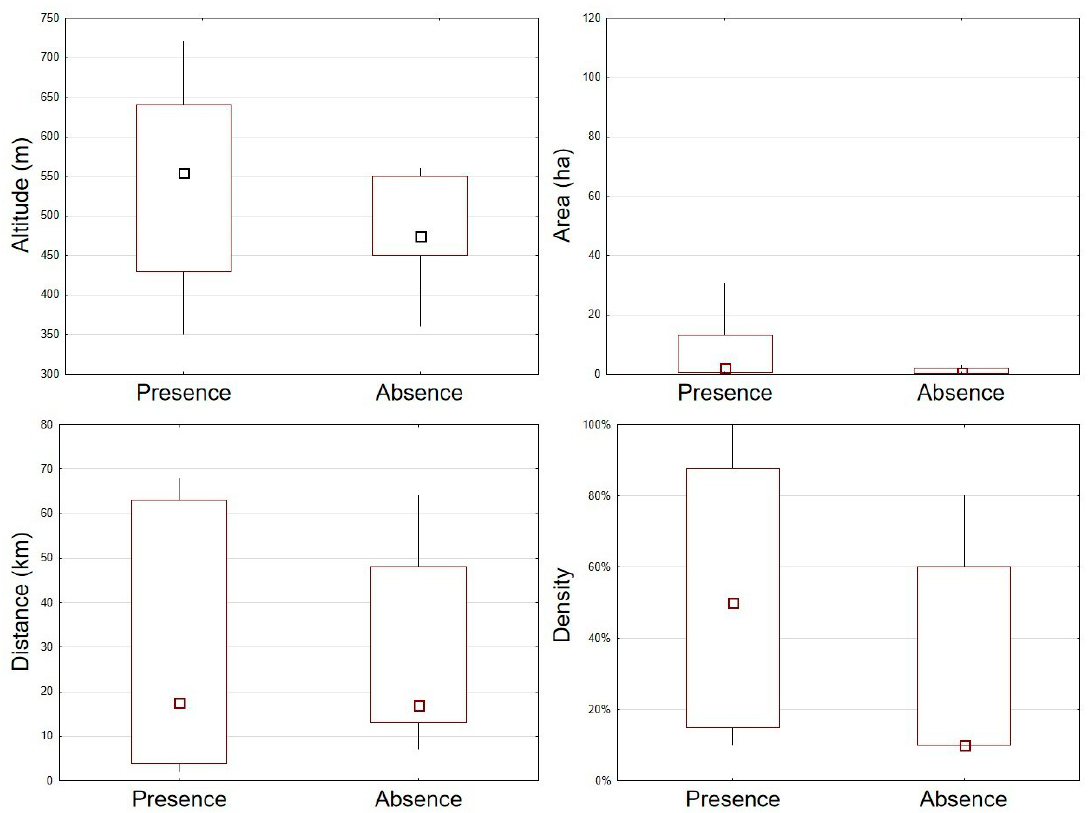
Figure 5. Relationships between the presence and absence of Phloeosinus aubei and the following characteristics of the localities: altitude, area, distance from the nearest juniper, and juniper population density. Small squares indicate medians, boxplots indicate the 25% and 75% quartiles, and lines indicate minimum and maximum values.